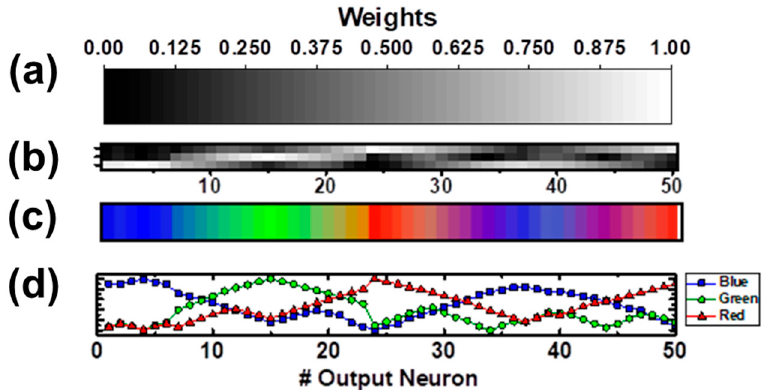
Figure 13. ( a ) Gray-scale used to represent the synaptic weights of the crossbar array. ( b ) 3 × 50 crossbar array displaying the normalized conductivity states of the simulated OxRAM devices after the learning stage. ( c ) Output neuron layer color assignation. The system shows a topographical or spatial organization of the RGB color components. ( d ) Activation response of the output neurons when a red (red line with diamonds), green (green dotted line), or blue (blue line with triangles) color is presented as an input.